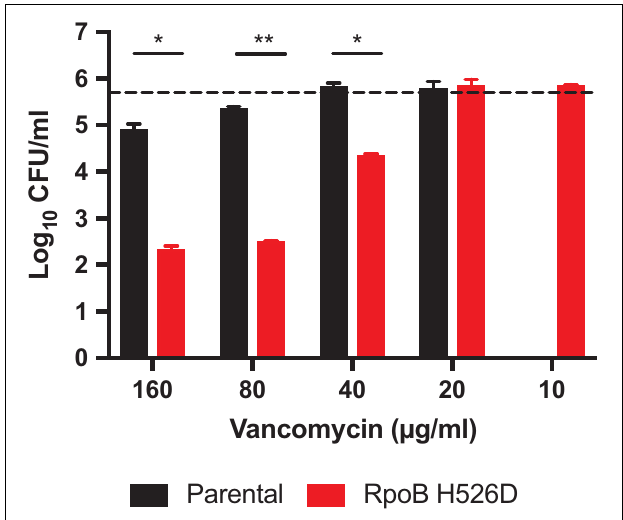
FIGURE 5 | RpoB mutation H526D is associated with increased Mtb susceptibility to vancomycin. Bactericidal activity of vancomycin against RpoB H526D mutant and parental strains. The dashed line indicates the cell number for each strain at the start of the experiment (5.75 ± 0.01 log 10 CFU/ml). ∗ p < 0.05, ∗∗ p <